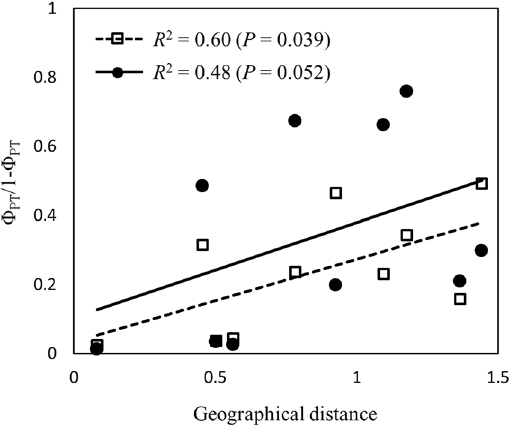
Figure 5. Standardized pairwise genetic distance ( Φ PT /(1 − Φ PT )) plotted against geographic distance among five Cercospora beticola populations in New York, 2015. The open squares and dashed line are based on the complete data set, and the filled circles and solid line are based on the clone-corrected data